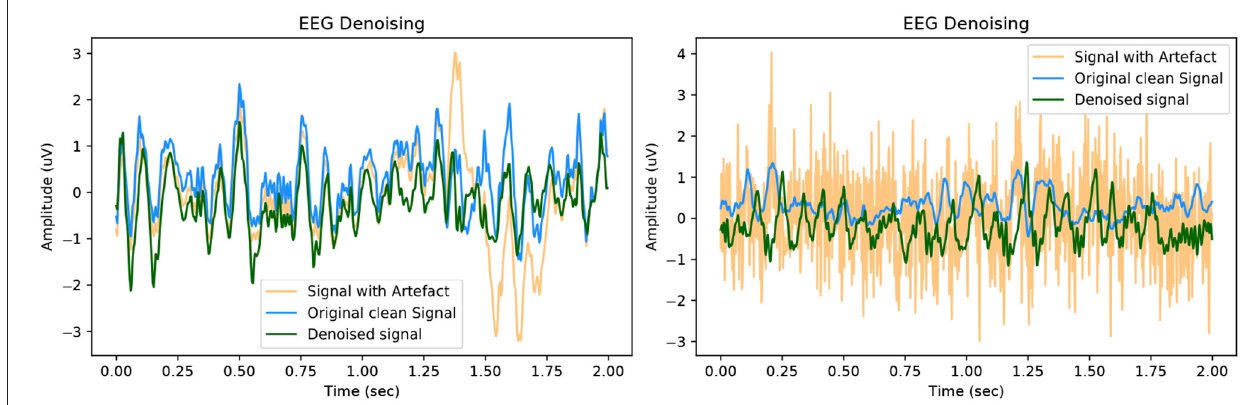
FIGURE 5 | Example of denoised time series EEG corrupted with (left) EOG artefact and (right) EMG artefact. The signals contain an artificial offset for visualisation purposes.